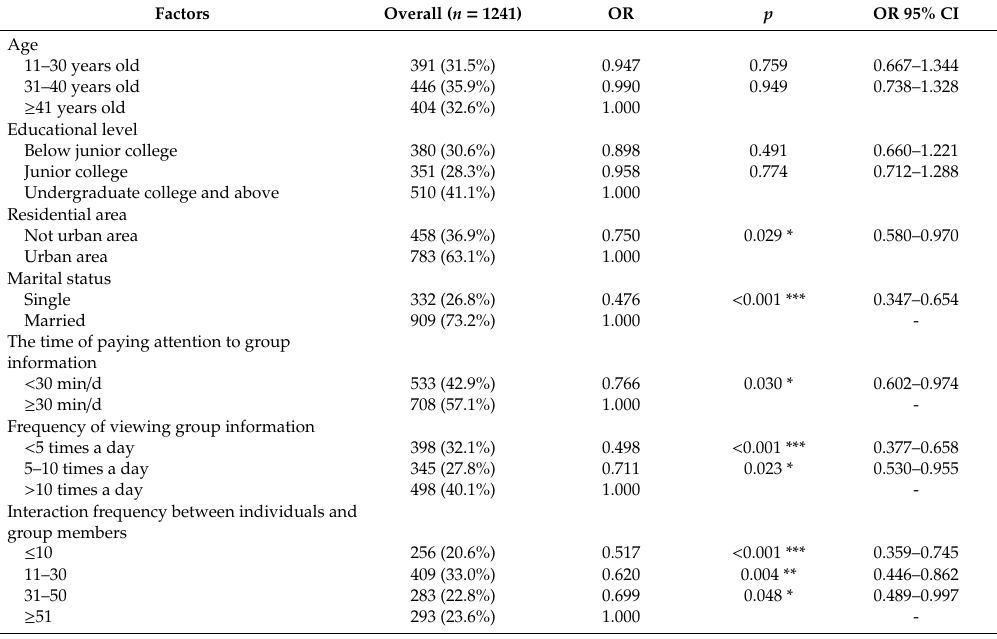
Table 4. Ordinal logistic regression analysis results for influence factors and self-e ffi